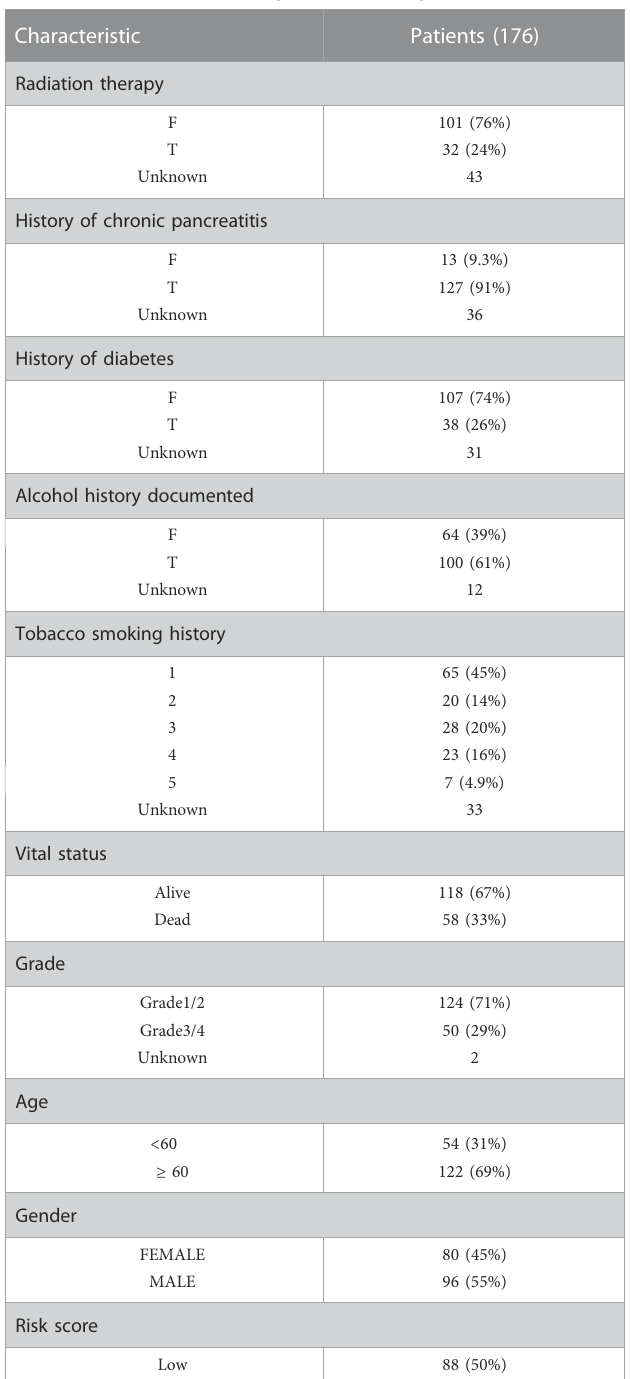
TABLE 1 Clinical characteristics of pancreatic cancer